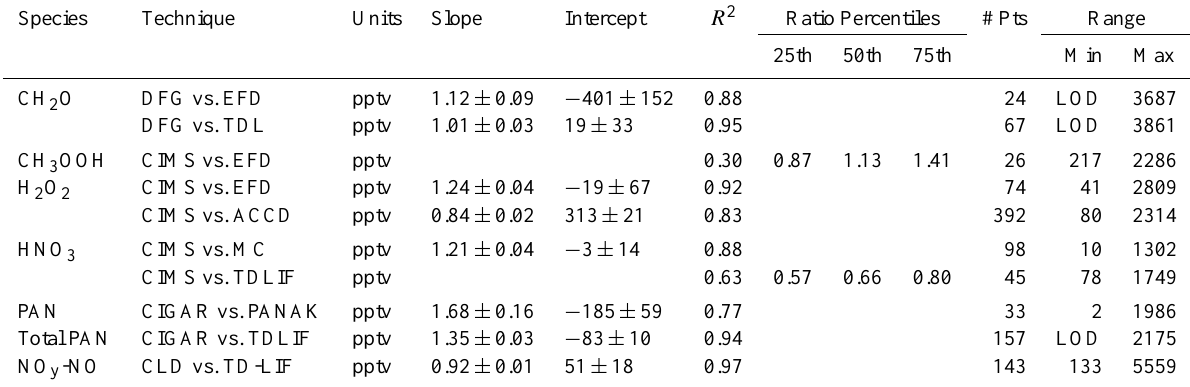
Table 3b. Statistical results of DC-8/C-130 intercomparison. Photochemical products. NOTE: Technique is listed as X (C-130) vs. Y (DC-8).